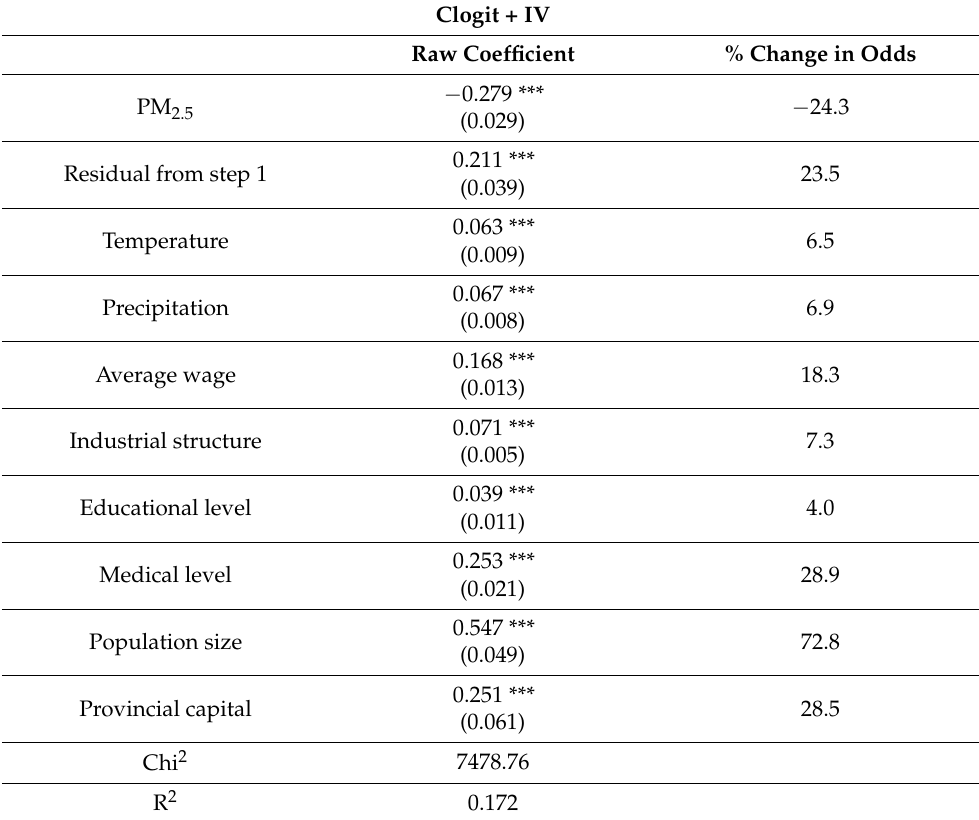
Table 4. Robustness check l: reasons for